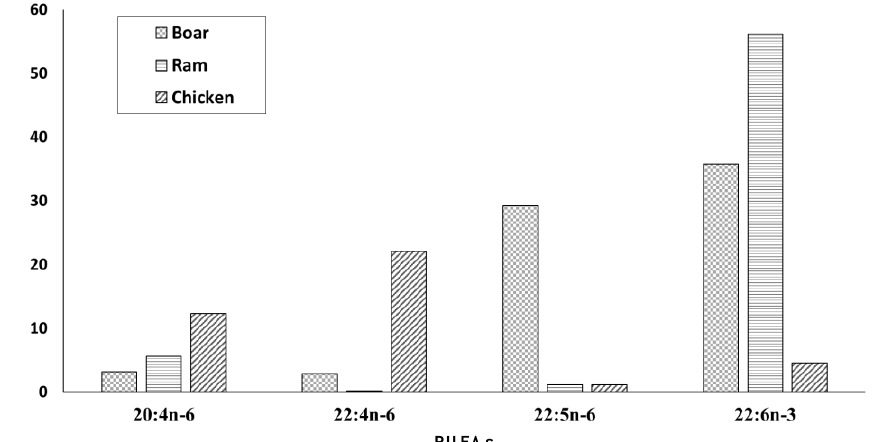
Figure 1. Polyunsaturated fatty acids (percentage of total fatty acids) in spermatozoa phospholipids (Adapted from Surai,